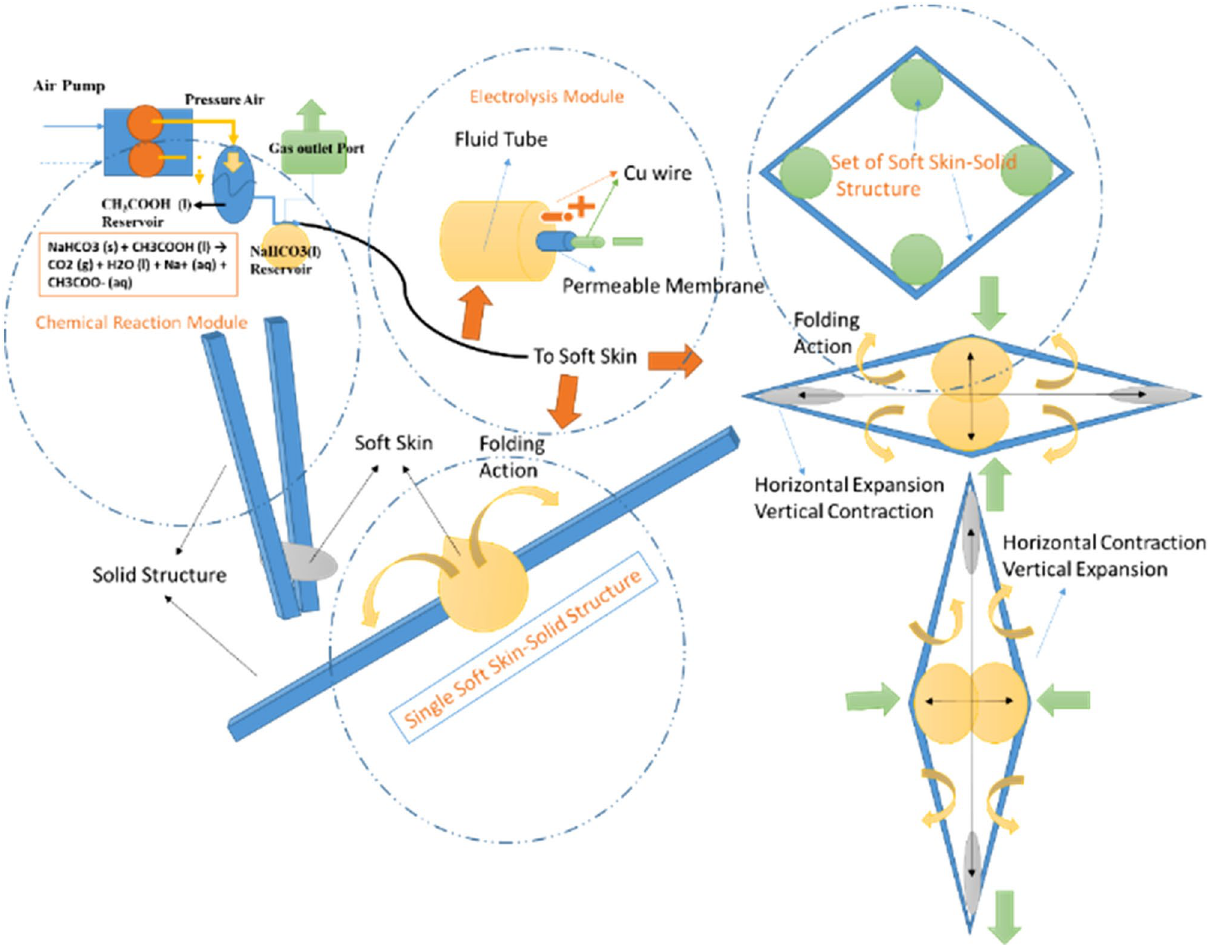
Figure 1. Principle of operation of HEFR in single soft skin-solid structure mode (just folding action in one direction) and set of soft skin-solid structure (bidirectional folding in which the fluid is flowing in it, is 5 mm with a wall thickness of 1 mm. One of the electrodes is placed in a very thin layer of cotton mesh with a thickness of 0.1 mm and is wrapped around the wire by a rotat-